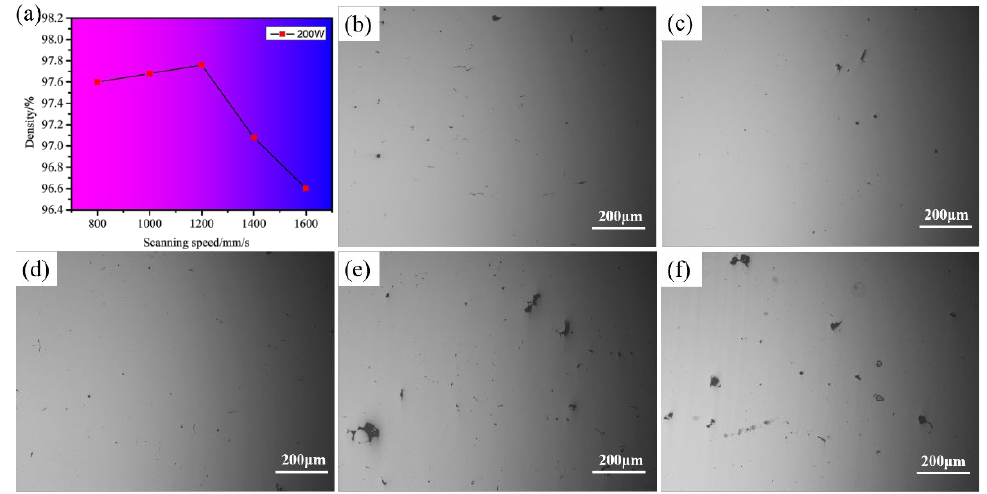
Figure 1. ( a ) Influence of different scanning speeds on relative density and ( b – f ) transverse section appearance: ( b ) 800 mm/s; ( c ) 1000 mm/s; ( d ) 1200 mm/s; ( e ) 1400 mm/s; ( f ) 1600 mm/s.